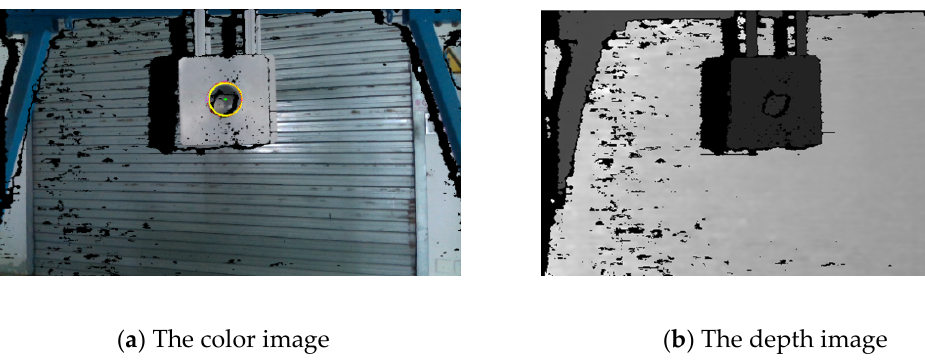
Figure 6. The color image and the depth image.